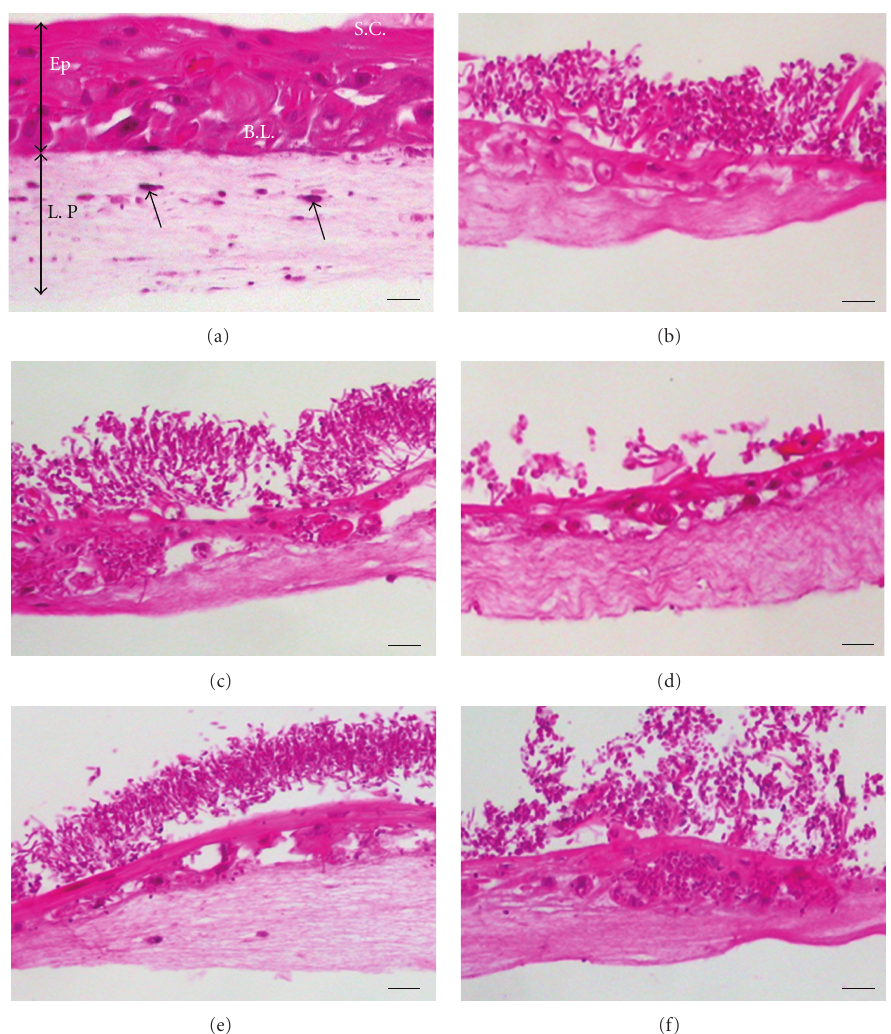
Figure 2: Interaction of ECM33 mutants with EHOM and biofilm formation. Histological features of the EHOM following 24 h of exposure to each C. albicans strain. (a) Noninfected EHOM tissue; (b) infected with CAF2 strain; (c) RML1; (d) RML2; (e) RML3; (f) RML4 C. albicans . The noninfected EHOM (a) displays an epithelium (Ep) containing a stratum corneum layer (SC), a basal layer (BL), and a collagen-containing lamina propria (LP) populated with fibroblasts (arrows). Scale bars, 30 μ m. Representative photographs of three di ff erent experiments are shown (two EHOMs per